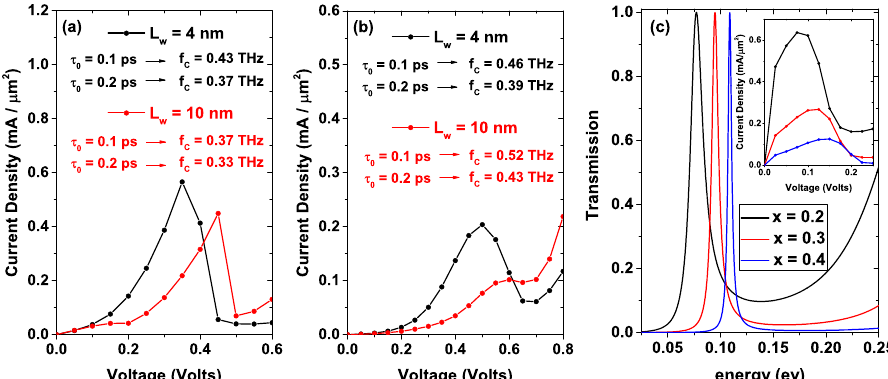
Figure 7. Tunneling current density for two different values of L w as a function of bias voltage, in ( a ) with n d = 1.2 × 10 18 [1/cm 3 ], and ( b ) with n d = 10 × 10 18 [1/cm 3 ]. Figure ( c ) shows the transmission for three different values of the Al concentration in the barriers, x = 0.2, 0.3, and 0.4 for a system of three regions Al x Ga 1 − x As/GaAs/Al x Ga 1 − x As. The inset shows the current density for these three systems taking L w = 4nm and L b = 3nm. In figures ( a , b ), the cut-off frequencies have been included for all the arrangements calculated (black text corresponds to L w = 4nm and red text corresponds to L w = 10nm) by taking two different values of τ 0 , 0.1ps and 0.2